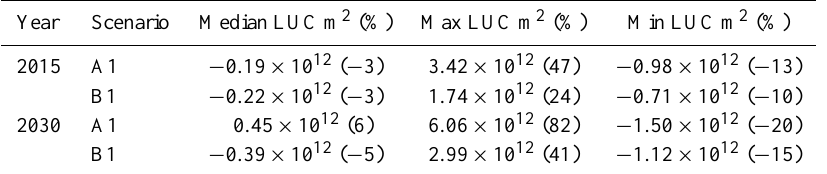
Table 4. Summary of change in global cropland area from 1990 to 2015 and from 2015 to 2030. For each IPCC AR4/SRES scenario the PLUM realizations corresponding to the median, maximum and minimum difference in global cropland area are shown. Changes in global cropland are discussed relative to 1990.